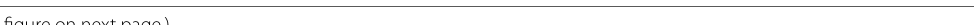
domain(See figure on next Fig. 11 Influence of target training data on learned models in Evaluation 3. a RMSE of the slip prediction and b KLD of the distribution are plotted for the models learned from the training data with different upper boundaries of terrain inclination. The results for the four target domains are shown. RMSE and KLD decrease along with the increase of the maximum terrain inclination included in the training data. The proposed MS-TGPR-based method (green) learned the model with relatively smaller RMSE and KLD even when the target data was limited to approximately 3 ◦ . Its performance was almost as good as that of the reference GPR model with data up to approximately 7.5–15 ◦ , depending on the target